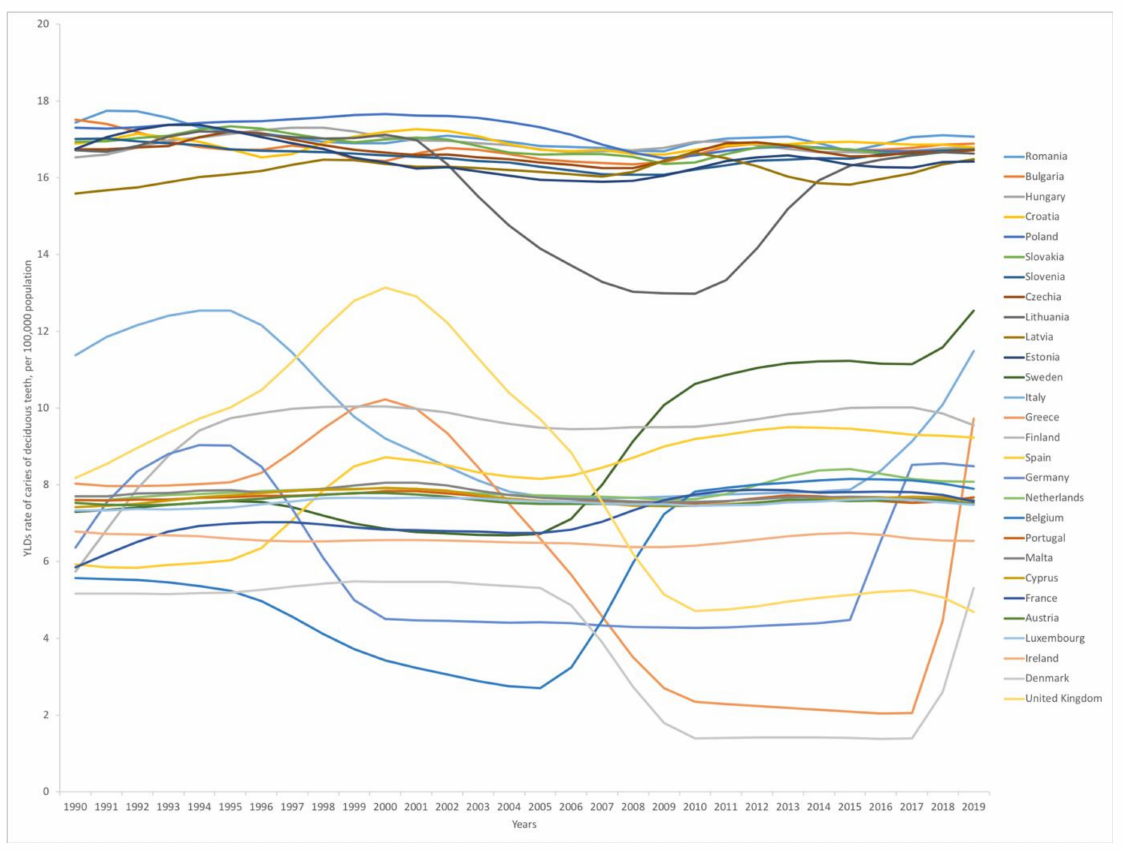
Figure 1. YLDs rate of caries of primary teeth per 100,000 population between 1990 and 2019 (presented age group: under 5 years of age). Source: Global Burden of Disease database. YLDs: years lived with